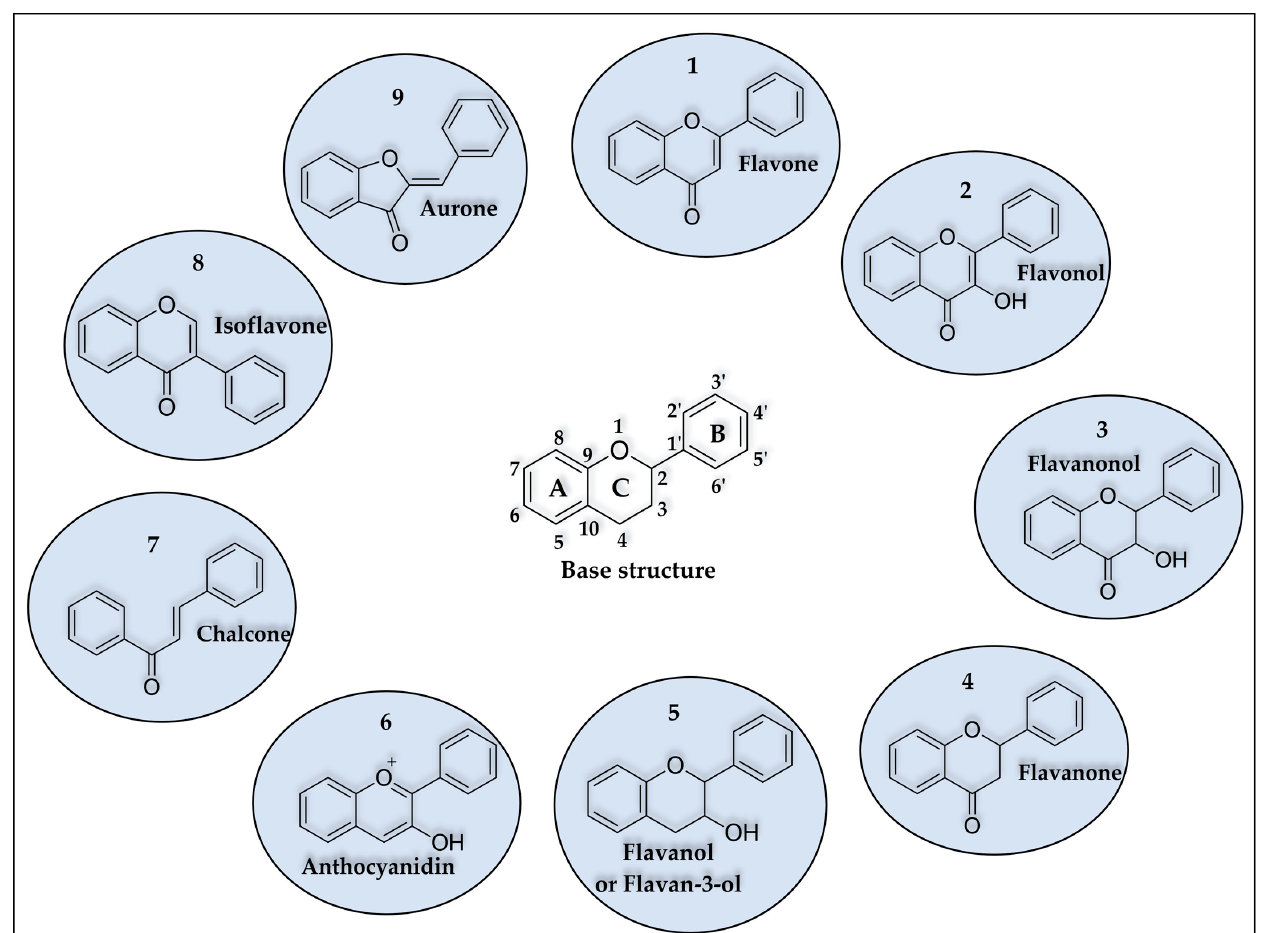
Figure 2. Base structure and classes of flavonoids. ( 1 ) flavone, ( 2 ) flavonol, ( 3 ) flavanonol, ( 4 ) fla- vanone, ( 5 ) flavanol, ( 6 ) anthocyanidin, ( 7 ) chalcone, ( 8 ) isoflavone, and ( 9 ) aurone.